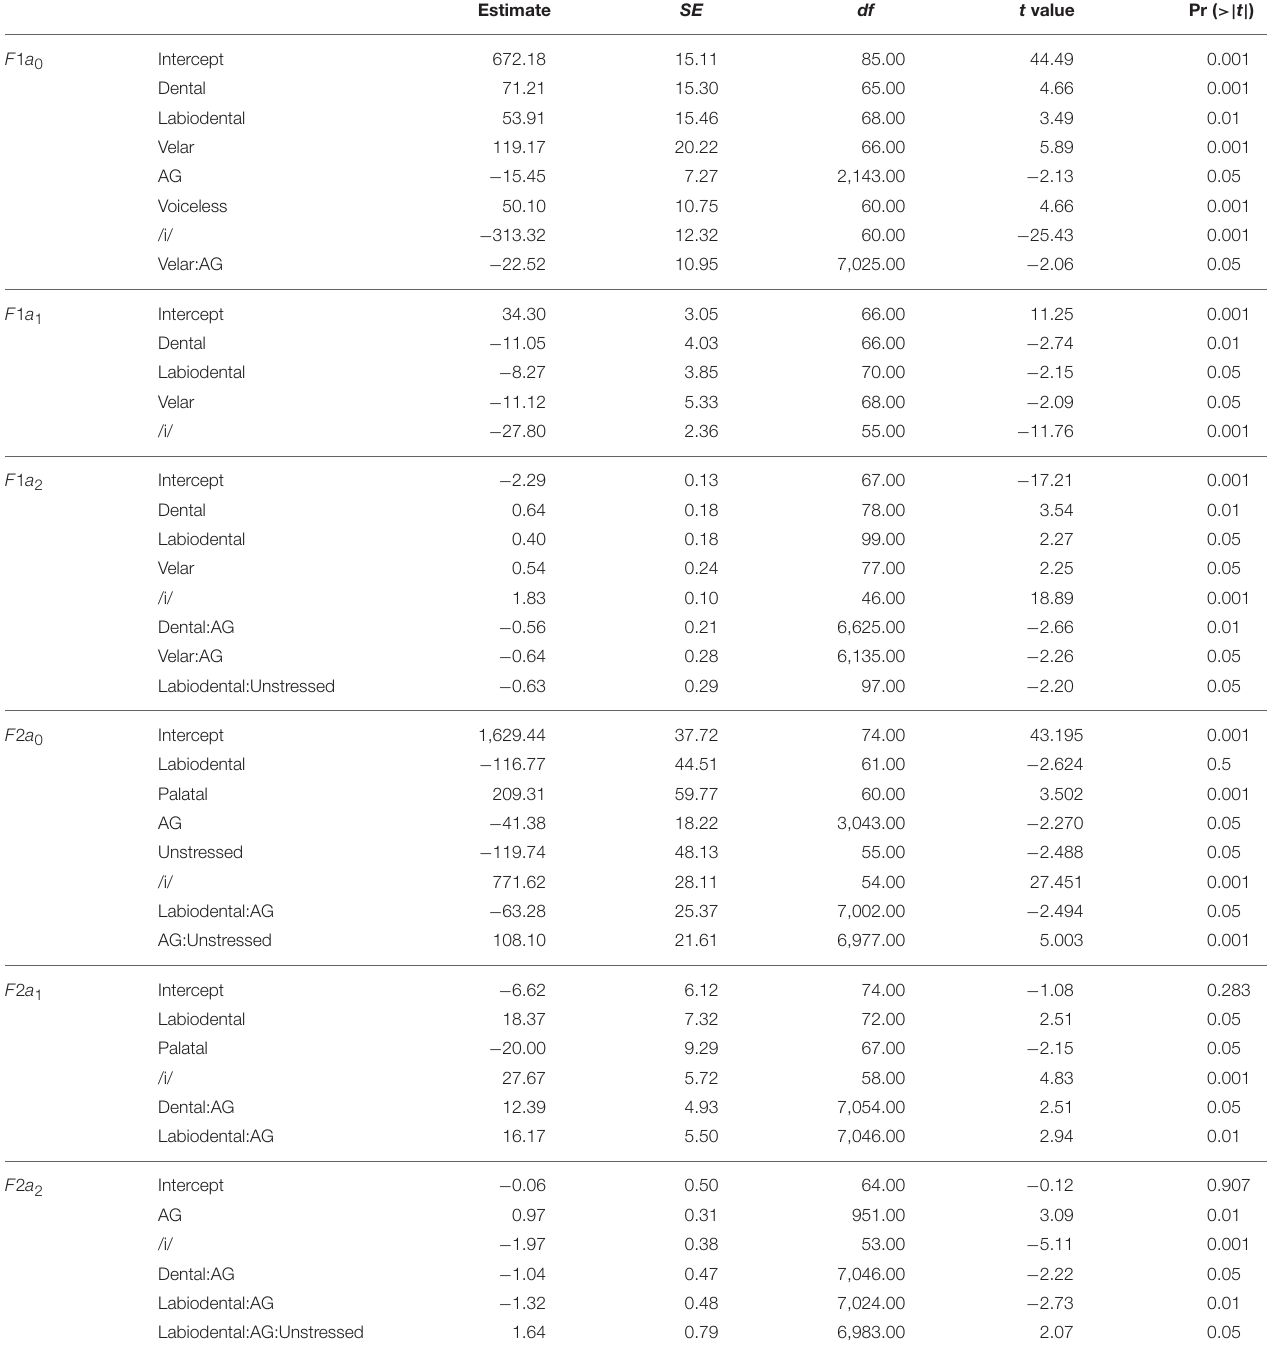
TABLE 8 | Effects of dialect [Athenian Greek (AG) and Cypriot Greek (CG)], place of articulation, voicing, stress, and vowel on the three polynomial coefficients of F 1 and F 2. Estimate